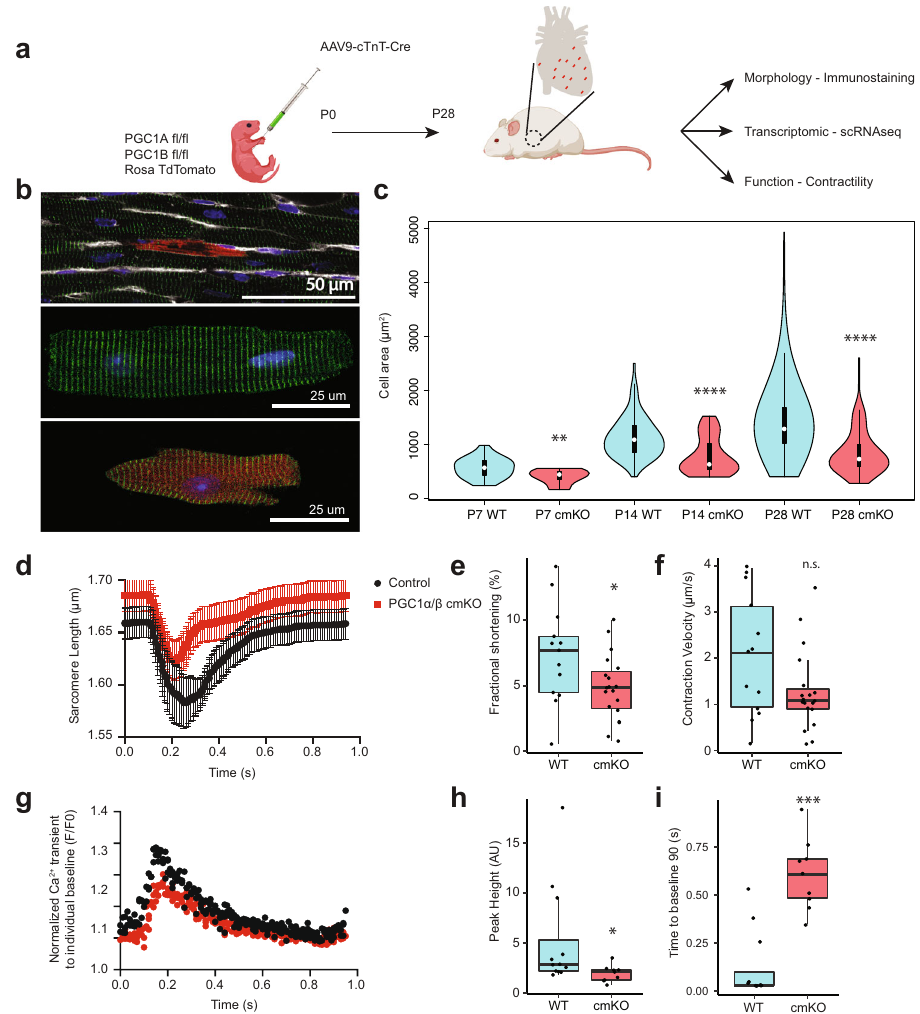
Fig. 3 PGC1 is required for CM hypertrophy and contractility development. a Experimental scheme showing generation and analyses of a cmKO heart achieved by injection of AAV9-cTnT-Cre into PGC1 α / β fl ox/ fl ox ; Ai9 mice at p0. b Heart slice showing a cmKO myocyte in the myocardium (top) and dissociated control (middle) and cmKO (bottom) myocytes. c Violin plots of cell area distributions in control (blue) and cmKO (red) CMs at p7 ( p -value = 0.003), p14 ( p -value = 2.5e − 7), p28 ( p -value = 2.2e − 16). n = 44, 11, 90, 49, 522, 132 (left to right). ANOVA followed by post hoc Bonferroni tests were used. d – f Sarcomere shortening data with the average trace, fractional shortening ( p -value = 0.047) and contraction velocity ( p -value = 0.07). Control n = whiskers plot represents the maxima, 75 th percentile, median, 25th percentile, and minima. P -value: